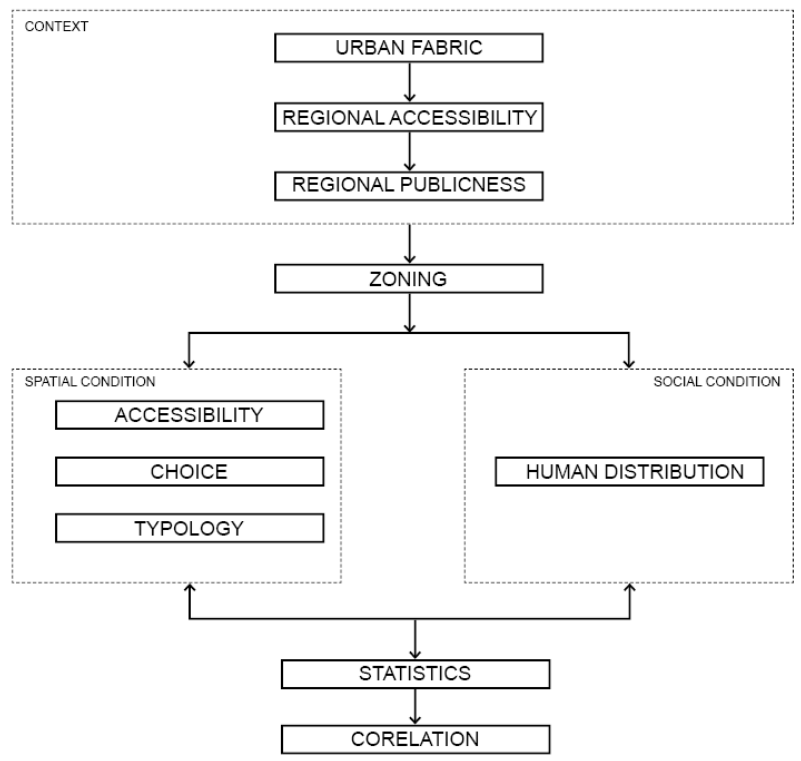
Figure 3. The publicness of public space in Xinjiekou area and the spatial morphology correlation research route. Table 1. Indicators and definitions of spatial publicness research.